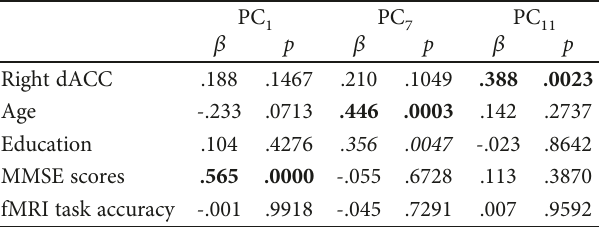
Table 2: Predictive power of right dACC activity on cognitive pro fi